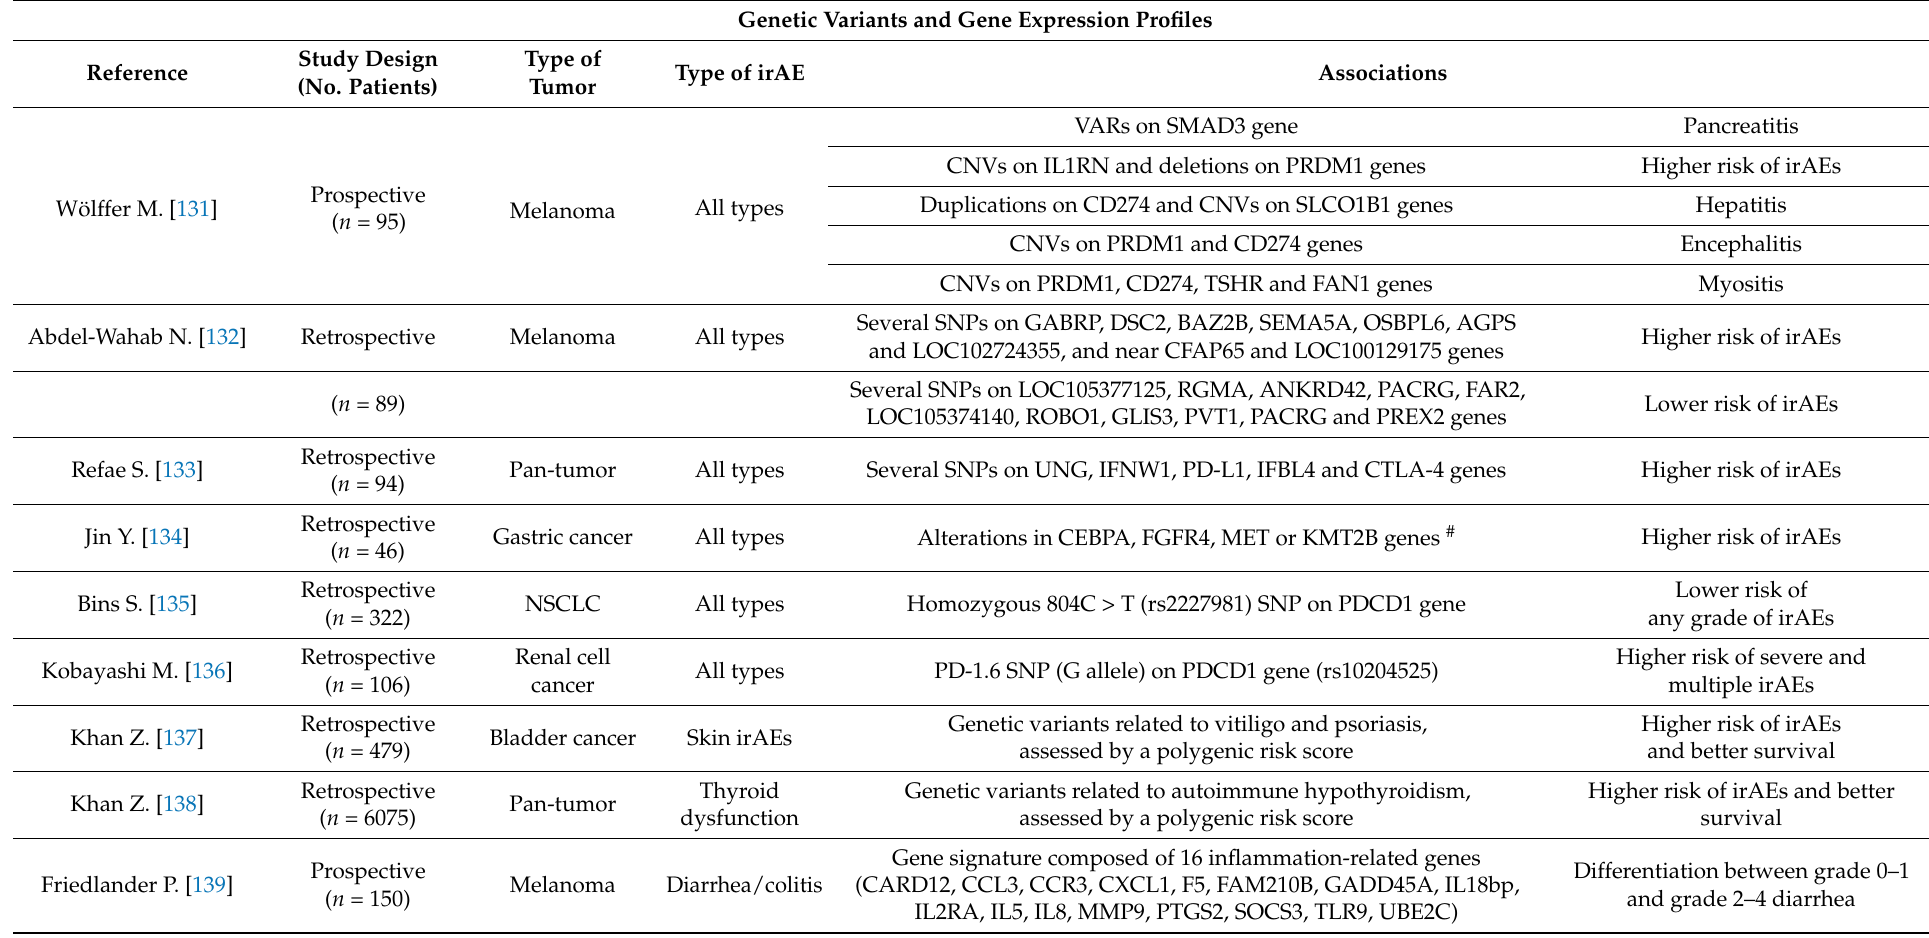
Table 3. Summary of studies on reported associations between immune-related adverse events and HLA system antigens, genetic variants and signatures and